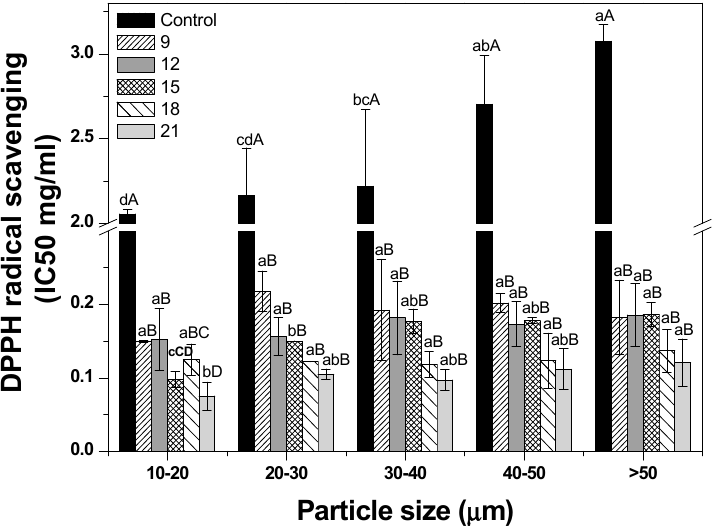
Figure 5. DPPH radical scavenging activity of dried ginseng powders with different particle sizes according to roasting time. After cryogenic milling of ginseng samples with different conditions, the samples were classified by their particle sizes. One treatment condition in each size range was then selected, and samples selected by particle size were then roasted and pulverized by cryogenic milling. a–c Means with different superscripts within the same time group are significantly different ( p < 0.05;